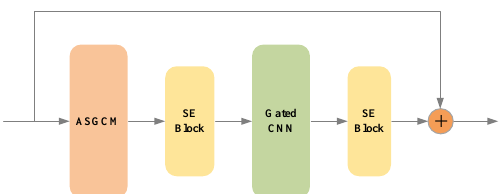
Figure 4. The gated action-specific convolution network. The ASGCM is used for spatial skeleton. The gated CNN is used for temporal sequences. The SE block is the channel-wise attention.